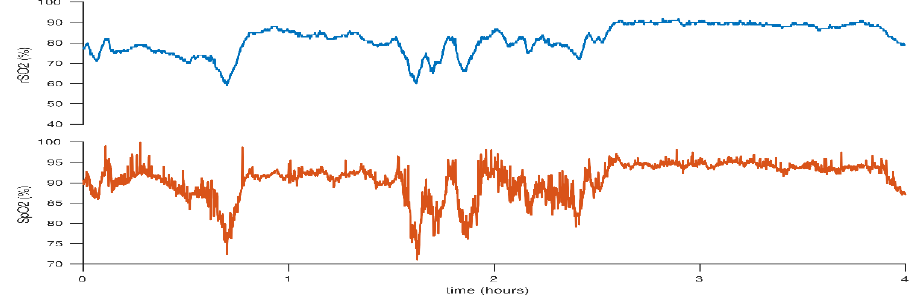
Figure 5. Decrease in cerebral rSO 2 associated with decrease in peripheral SpO 2 due to desaturations. The subsequent overshoot is likely due to the increased FiO 2 .This figure reflects the case of a neonate born at 25 + 2 weeks gestation. BW 530 g, DOL 3.